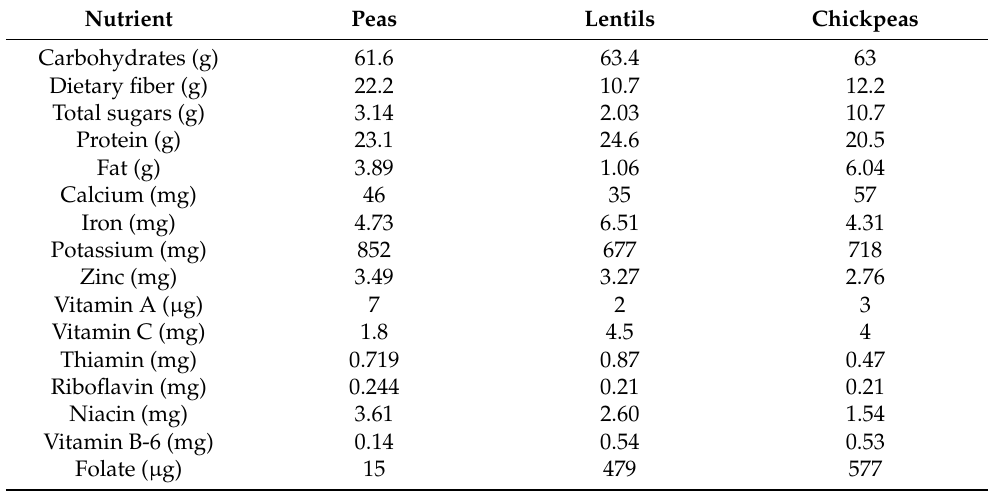
Table 2. Nutritional composition of dry peas, lentils, and chickpeas (value per 100 g of whole seed flour). Nutrient Peas Lentils Chickpeas Carbohydrates